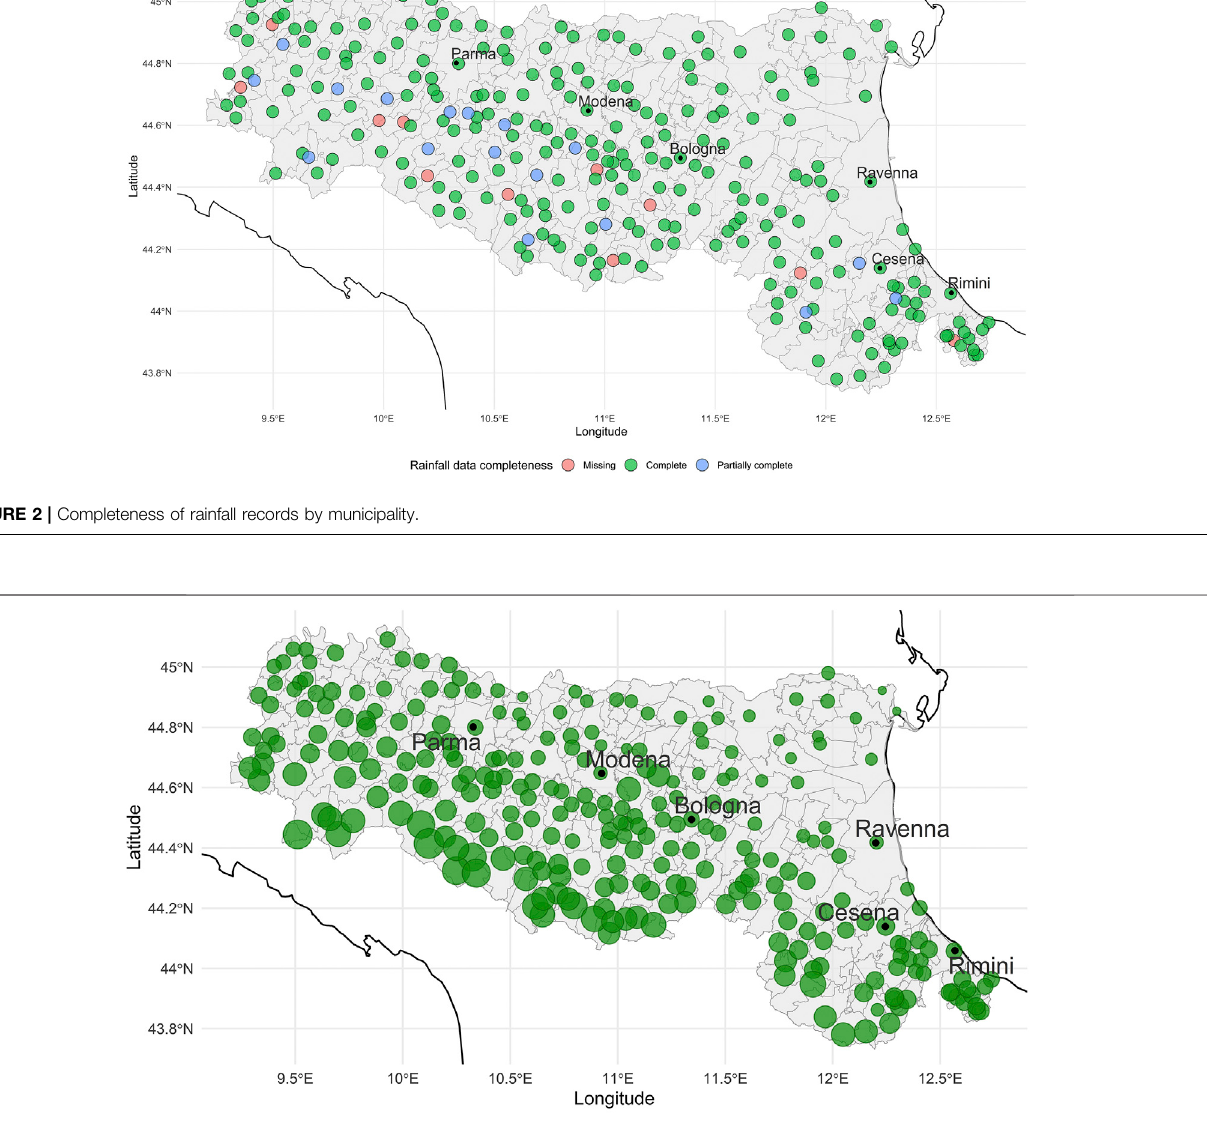
Frontiers in Earth Science |